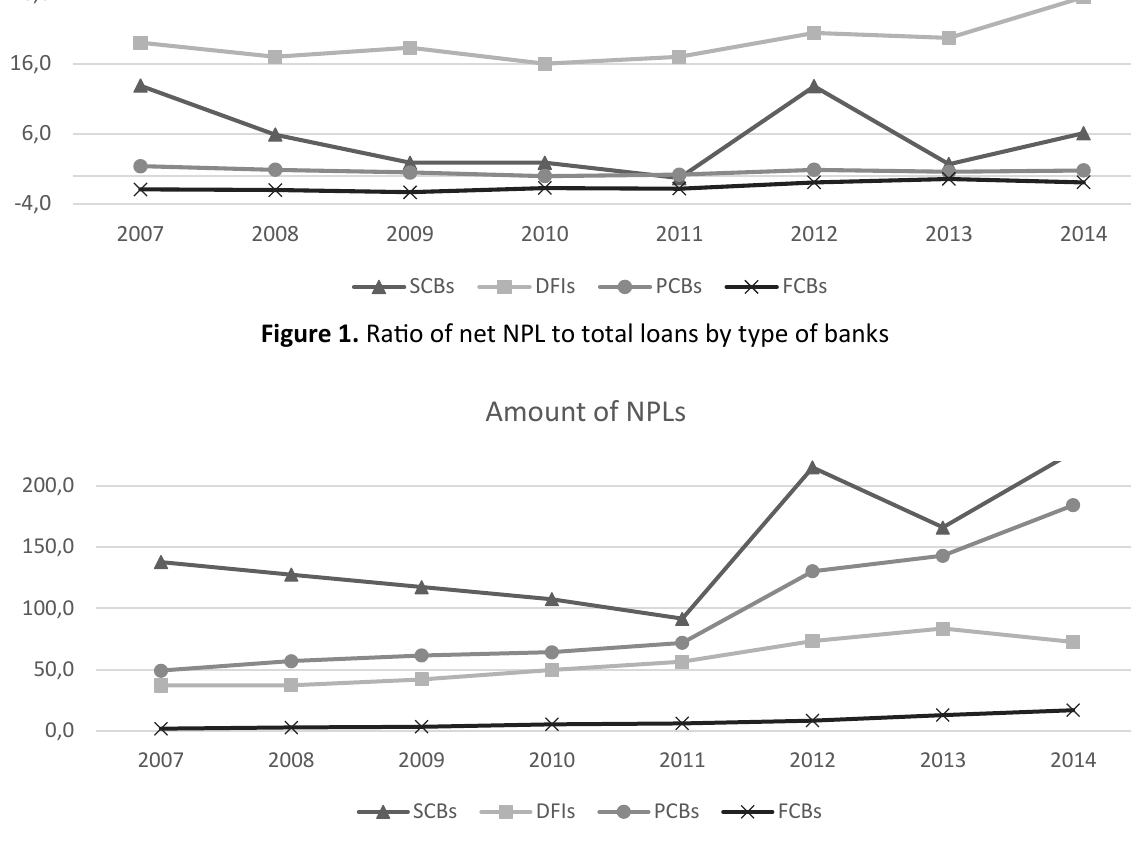
Figure 2. Amount of NPL to total loans by type of